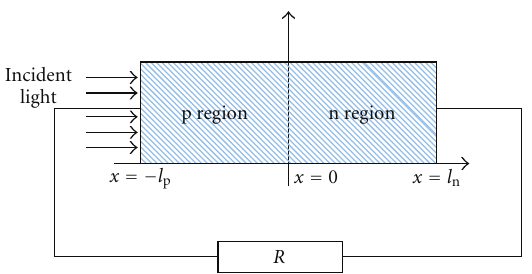
Figure 1: Solar cell diode with an external resistor